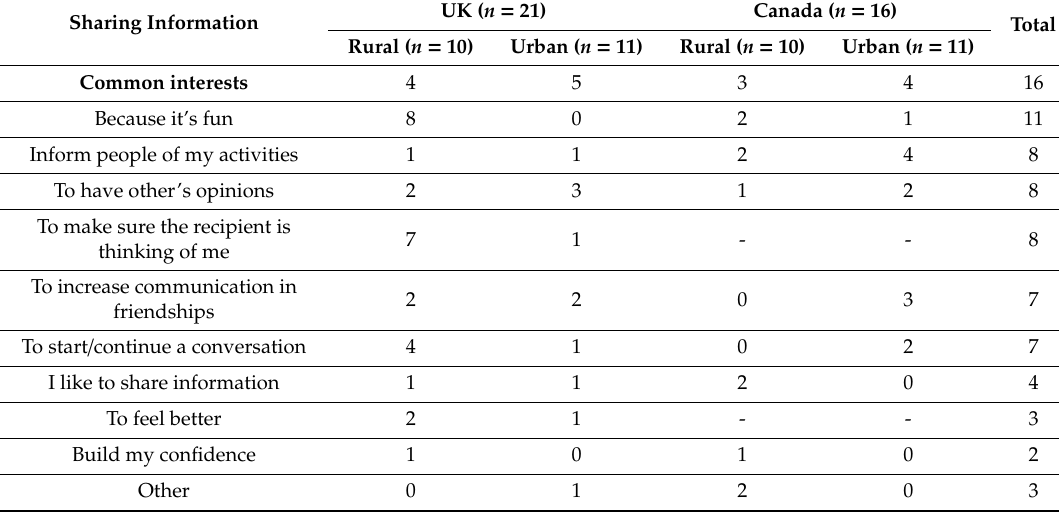
Table 7. Self-logging activities by country (UK and Canada) and location (rural and urban)